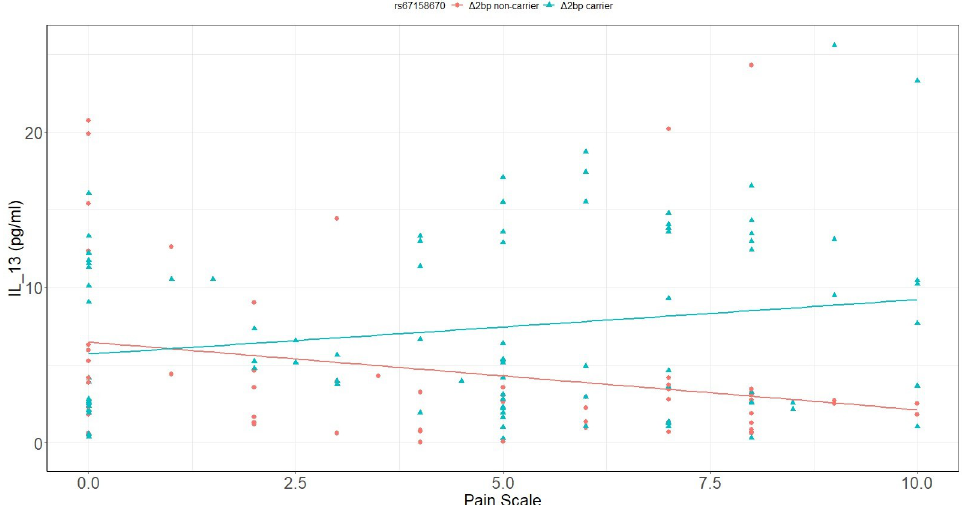
Fig 2. Association of IL-13 with pain scale in severe SCI is a function of Δ 2bp variant.